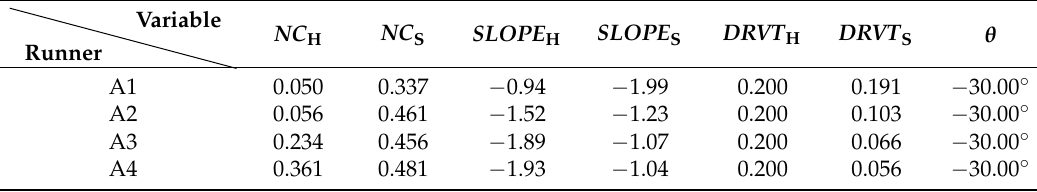
Table 4. Optimized parameters by the first step optimization.